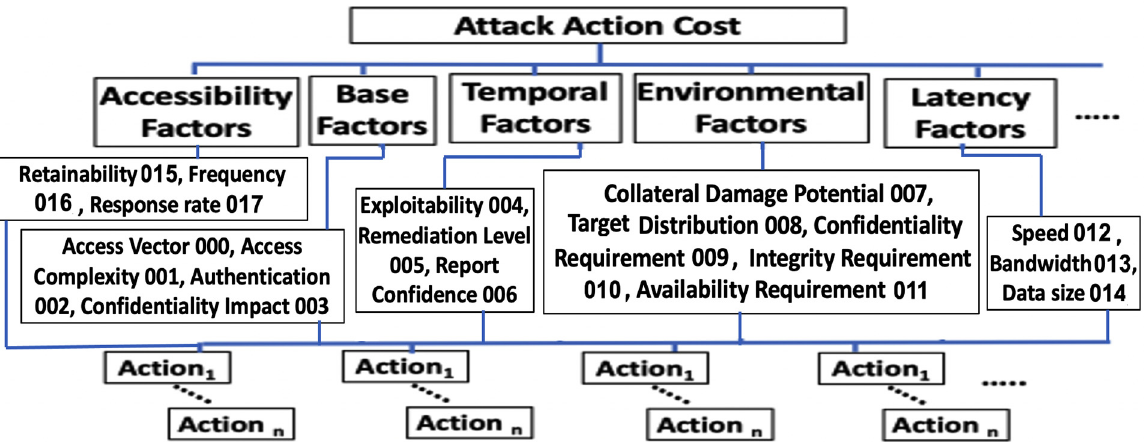
Figure 6. The Hierarchical GG with corresponding factors’ codes.